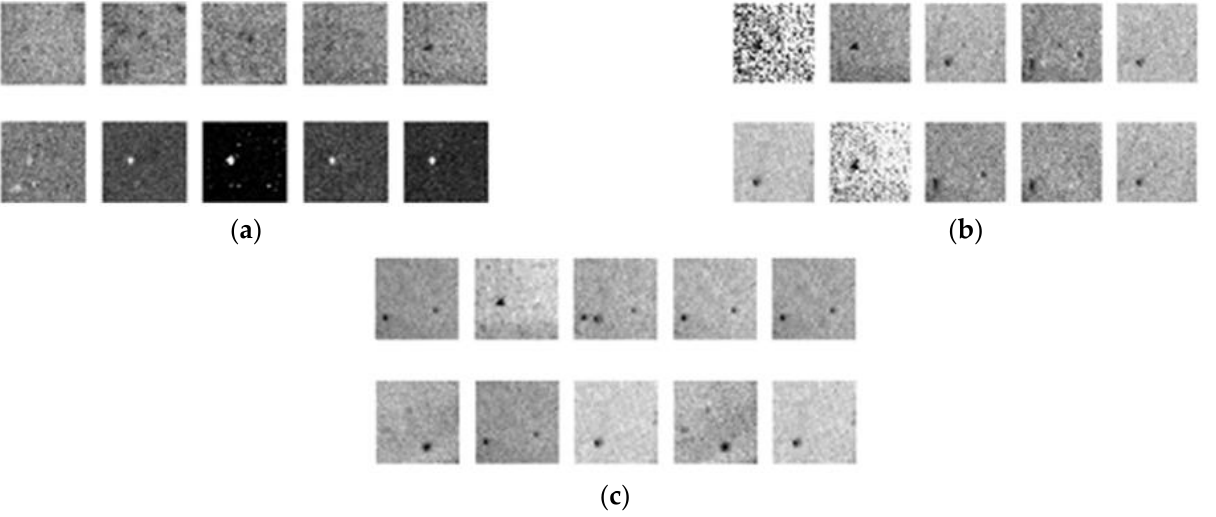
Figure 20. DCGAN training results: ( a ) 10,000 iterations; ( b ) 20,000 iterations; ( c ) 30,000 iterations. A comparison of the images generated using DCGAN (30,000 iterations) and actual images (Figure 21) revealed that the proposed dataset augmentation scheme was highly effective in generating a diversity of realistic defects. Generated images (640 × 480) were then stored for use in training YOLO.